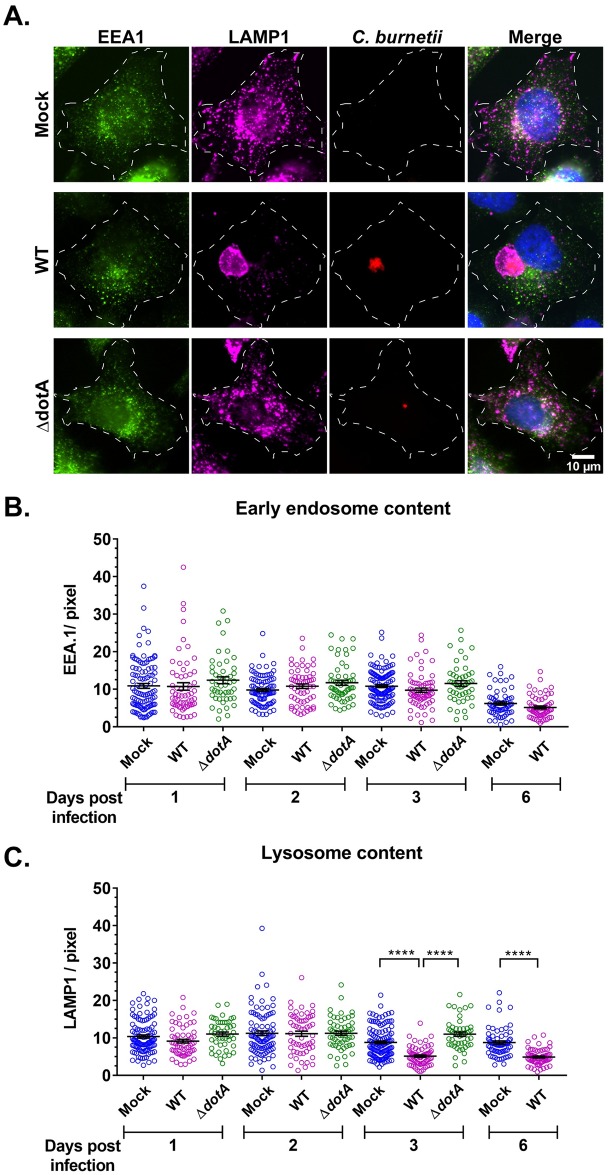
C. burnetii T4BSS reduces lysosomal content.(A) Representative images of EEA1 (early endosome marker) and LAMP1 (lysosome marker) immunofluorescent staining in mock and infected HeLa cells. Mock, WT, and ΔdotA-infected HeLa cells were immunostained with anti-EEA1, anti-LAMP1, and anti-C. burnetii antibodies. (B, C) Quantitation of EEA1 and LAMP1 intensity, normalized to cell area, revealed significant reduction in LAMP1 in WT C. burnetii-infected cells starting 3 dpi. Each circle represents an individual cell. Data shown as mean±SEM of at least 20 cells per condition in each of three independent experiments as analyzed by one-way ANOVA with Tukey’s posthoc test; ****, P<0.0001.